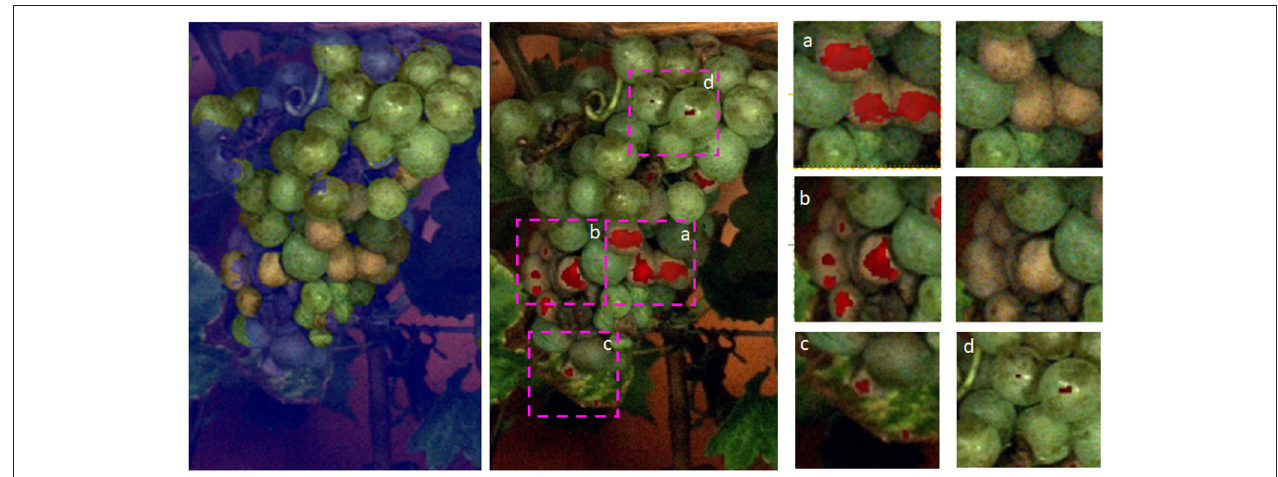
FIGURE 9 | Results for a whole grape bunch. On the left, the applied mask can be seen, which is provided by the CNN. The mask is not perfect but as assumed the damaged areas are in close vicinity to healthy berries. In the middle, we see the predictions of our FPL-VAE in red. we extracted patches and show them in detail on the right